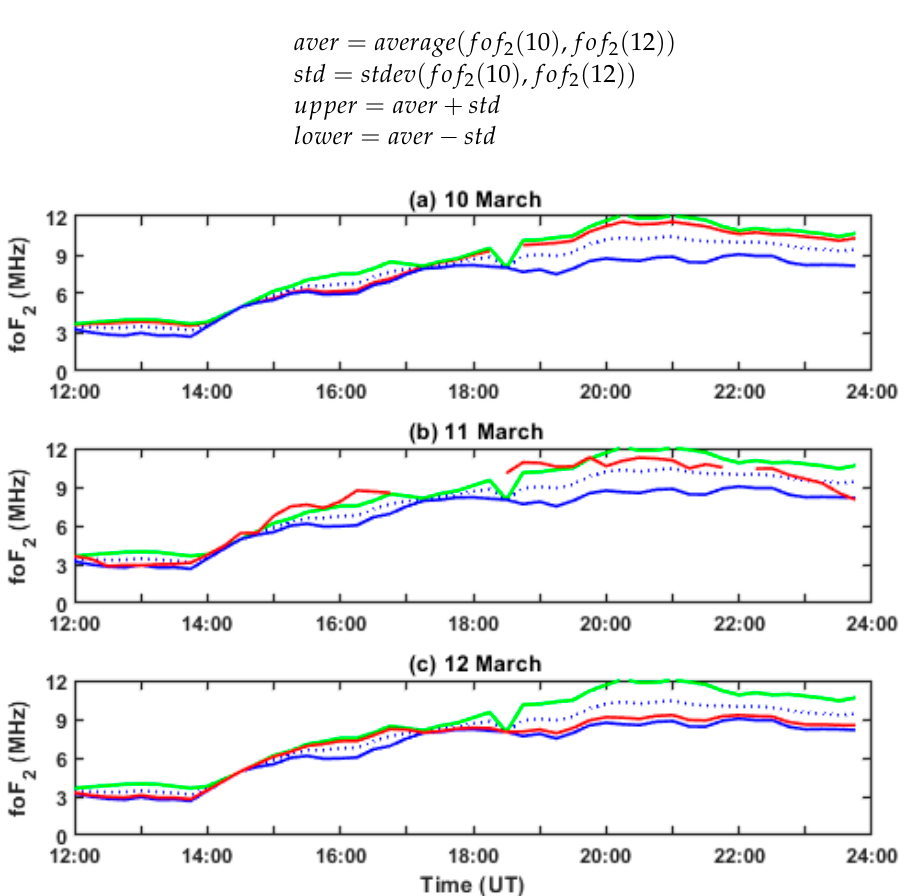
Figure 15. Variations in the ionospheric parameter foF 2 obtained at PA836 from 10 to 12 March 2011 (red line), for (a) 10 th , (b) 11 th , and (c) 12 th March 2011. The solid blue line is lower values of foF 2 parameter on quiet days (10 and 12 March 2011). The solid green line is upper values of foF 2 parameter on quiet days (10 and 12 March 2011). Blue dot line is the average of quiet day values (10 and 12 March 2011).